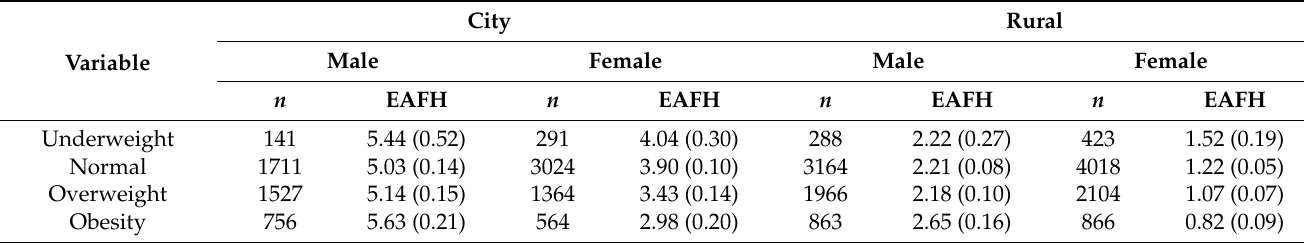
Table A3. Distribution of frequencies of eating-away-from-home (EAFH) of different BMI in urban and rural adults aged 18–44